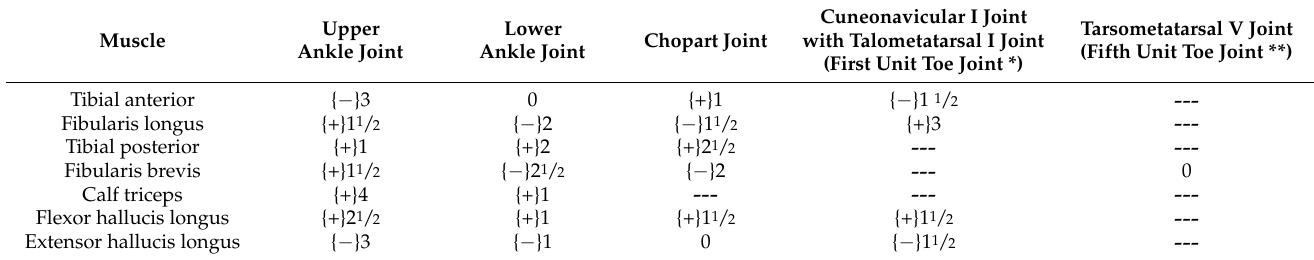
rotation of a given joint to the pulling of a given muscle (the shortest distance). The symbols {+} and { − } indicate the position of the tendon in relation to the joint axis. The upper ankle joint: {+} behind, { − } in front; the lower ankle joint (Henke axis): {+} medially, { − } laterally; Chopart joint (longitudinal axis): {+} medially, { − } laterally. Zero {0} means that the pulling of muscle runs parallel to the joint’s axis of rotation. Lack of data {